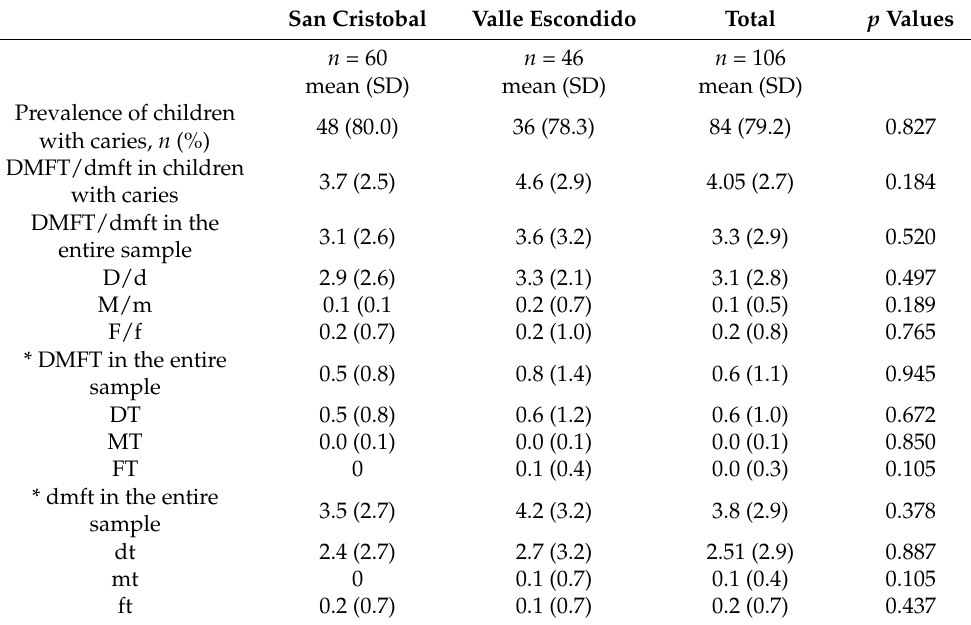
Table 3. Caries figures in the study population. San Cristobal Valle